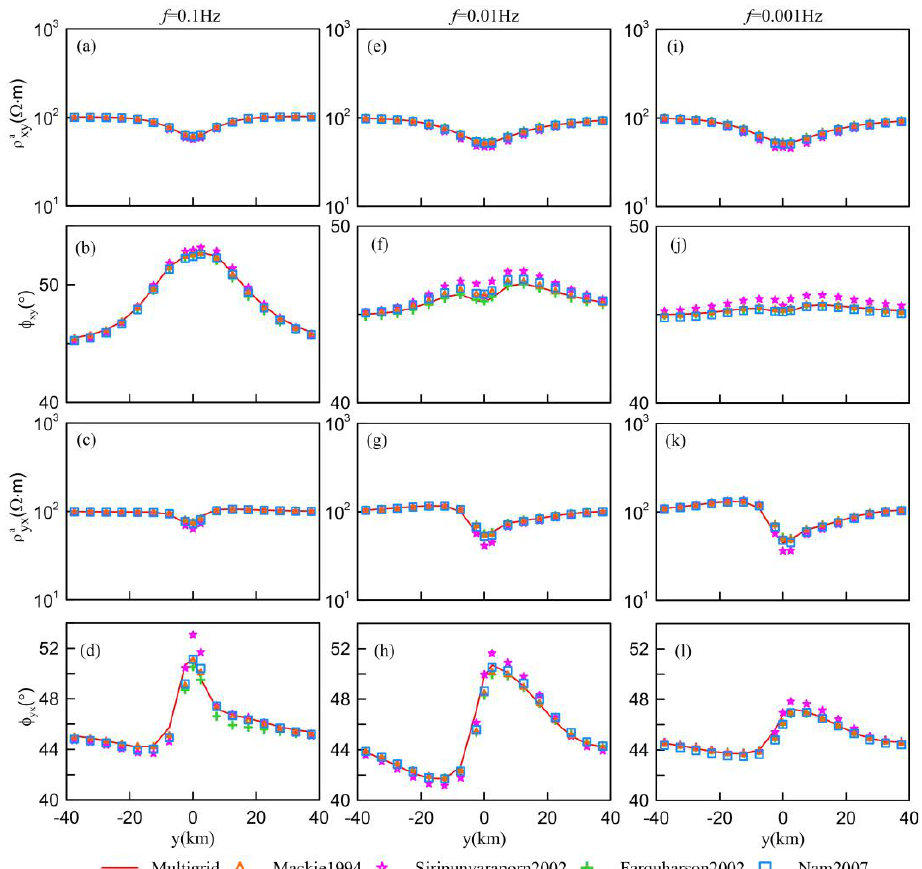
Figure 11. Apparent resistivities and phases calculated for the DTM1 model at frequency of 0.1, 0.01 and 0.001 Hz along the survey line x = 0. ( a ) ( e ) ( i ) and ( b ) ( f ) ( j ) are respectively the apparent resistivities and phases for the frequencies of 0.1, 0.01, 0.001hz in x -polarization mode, while ( c ) ( g ) ( k ) and ( d ) ( h ) ( l ) are respectively the apparent resistivities and phases for the same frequencies in the y -polarization mode. The red lines display the results of our MG algorithm, while the orange triangles, purple stars, green crosses, and the blue squares display the results calculated using the code developed by Mackie et al. [13] , Siripunvaraporn et al. [57] , Farquharson et al. [58] and Nam et al. [59] , respectively.